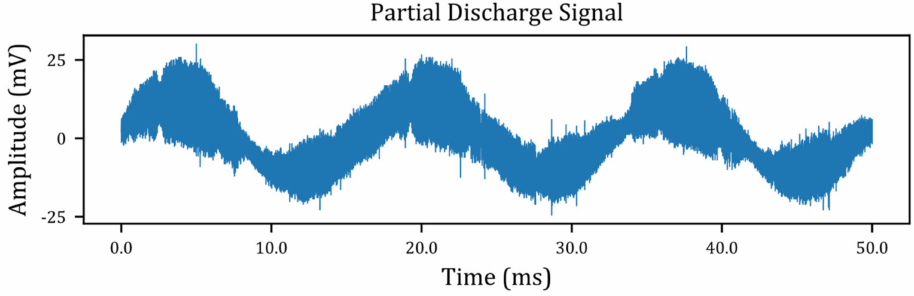
Figure 7. Example of a collected signal showing an intense activity of partial